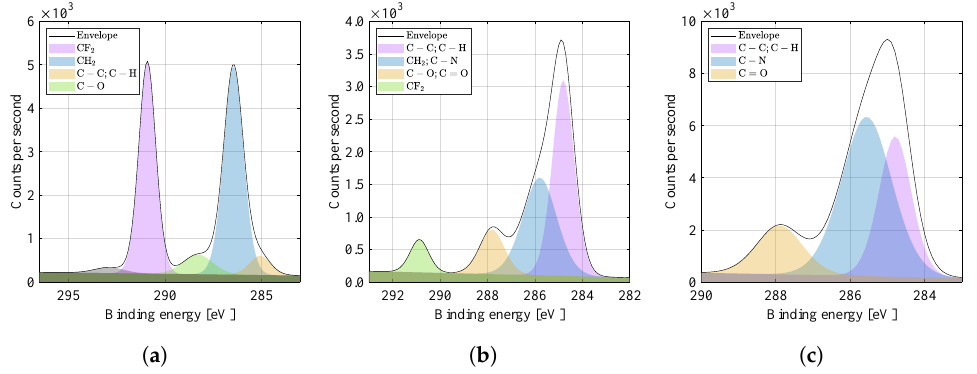
Figure 7. High energy resolution XPS spectra of C1s region. Nanofibers from the ( a ) PVDF, ( b ) PVDF/PA, ( c ) PA6 and their specific binding energies are